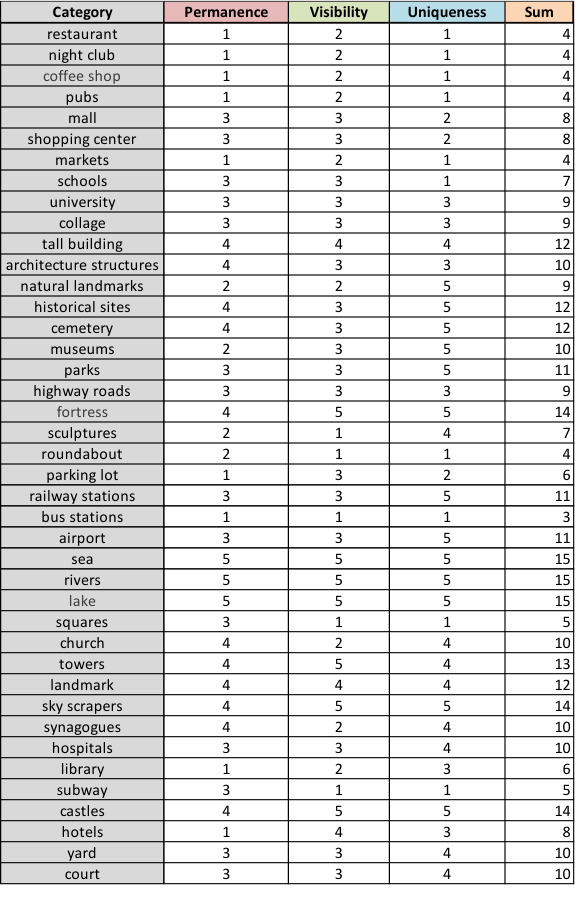
Table 2. Scoring of common landmarks based on the